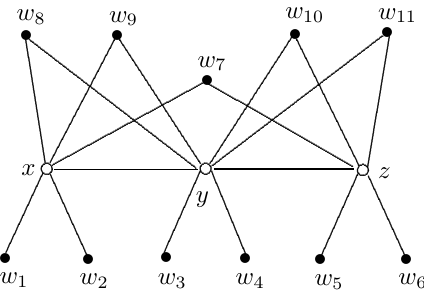
Figure 4: A connected spanning subgraph F of K